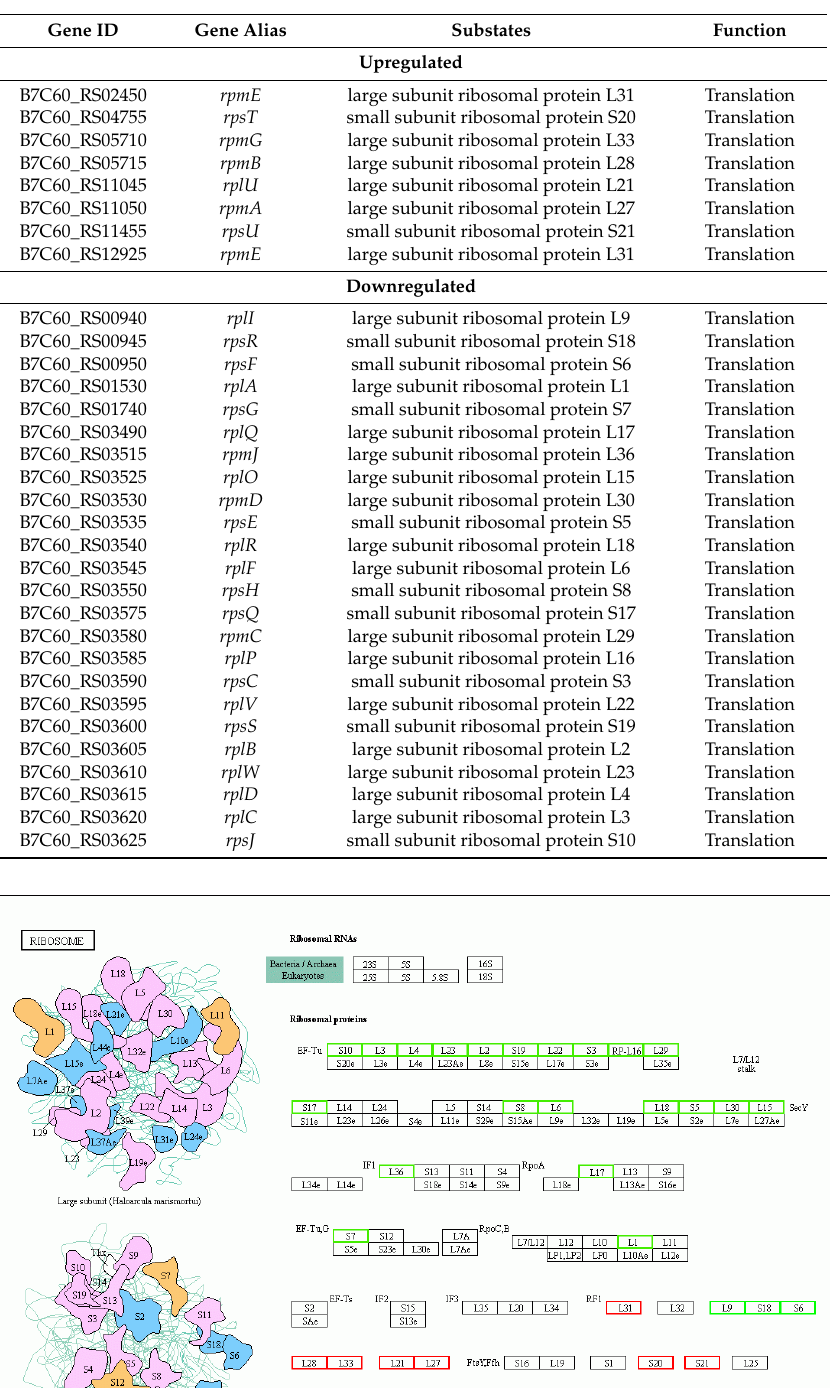
Table 3. Di ff erentially expressed candidate genes involved in the ribosome pathway.